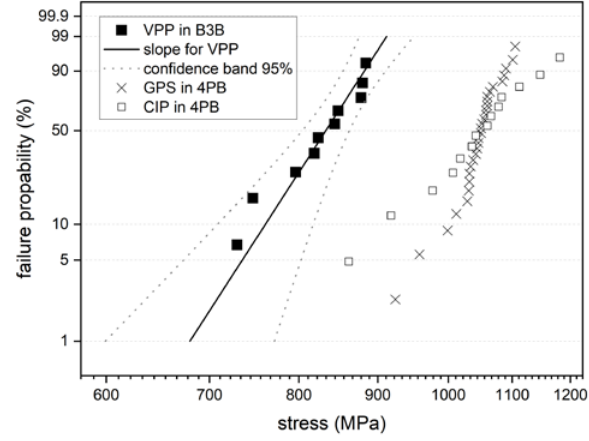
Figure 7. Weibull diagram for via vat photopolymerization manufactured (VPP) and cold isostatic pressed (CIP) binder based Si3N4 (adapted and redrawn from Ref. [24] 2022 Elsevier Ltd.), in comparison to gas pressure sintered (GPS) high strength Si3N4 (adapted and redrawn from Ref. [49] 2020 Elsevier Ltd.).